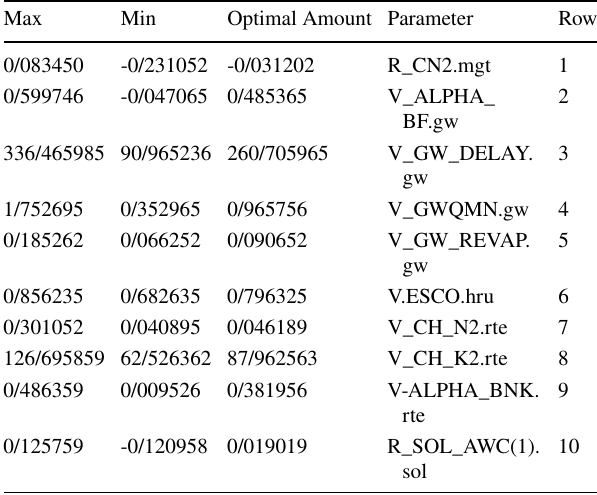
Table 2 Optimum standards of sensitive components after calibration for the study zone